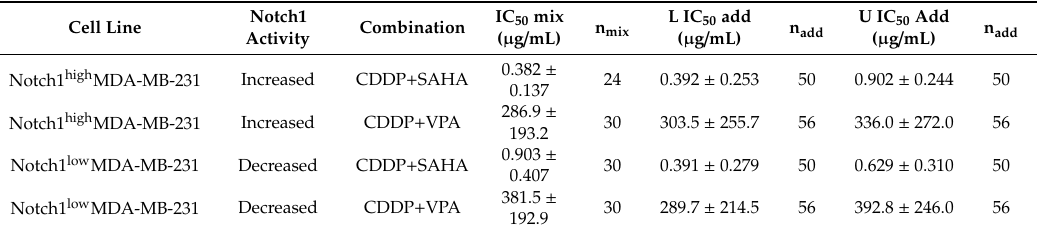
( A ) Isobologram illustrating additive interactions between CDDP and SAHA with respect to their anti-proliferative e ff ects on the MDA-MB-231 cells with the increased activity of Notch1 (Notch1 high MDA-MB-231); ( B ) isobologram illustrating additive interactions between CDDP and VPA with respect to their anti-proliferative e ff ects on the MDA-MB-231 cells with increased activity of Notch1 (Notch1 high MDA-MB-231); ( C ) isobologram illustrating additive interactions between CDDP and SAHA with respect to their anti-proliferative e ff ects on the MDA-MB-231 cells with decreased activity of Notch1 (Notch1 low MDA-MB-231); ( D ) isobologram illustrating additive interactions between CDDP and VPA with respect to their anti-proliferative e ff ects on the MDA-MB-231 cells with decreased activity of Notch1 (Notch1 low MDA-MB-231). The IC 50 ± S.E.M. for CDDP, SAHA, and VPA are plotted graphically on the X- and Y- axes, respectively. The lower and upper isoboles of additivity represent the curves connecting the IC 50 values for CDDP and SAHA, or VPA administered alone. The points A’ and A” depict the theoretically calculated IC 50 add values ( ± S.E.M.) for both, lower and upper isoboles of additivity. The point M on each graph represents the experimentally-derived IC 50 mix value ( ± S.E.M.) for the total dose of the mixture, which produced a 50% anti-proliferative e ff ect in the cancer cell line MDA-MB-231. The experimentally-derived IC 50 mix value is placed close to the point A’ for the lower isobole of additivity ( A ), ( B ), indicating additive interaction between CDDP and SAHA or CDDP and VPA in MDA-MB-231 breast cancer cells with increased expression of Notch1 (Notch1 high MDA-MB-231). The experimentally-derived IC 50 mix value is placed above the point A” ( C ) or close to the point A” for the upper isobole of additivity ( D ), indicating an additive interaction between CDDP and VPA, and additive interaction with a tendency towards antagonism between CDDP and SAHA in the MDA-MB-231 cells with the decreased activity of Notch1 (Notch1 low MDA-MB-231). Table 2. Type I isobolographic analysis of interactions (for non-parallel log-probit dose–response relationship curves (DRRCs) between CDDP and SAHA or VPA at the fixed-ratio combination of 1:1 in MDA-MB-231 with increased (Notch1 high MDA-MB-231) or decreased (Notch1 low MDA-MB-231) activity of Notch1 measured in vitro by the MTT assay. Results are presented as median inhibitory concentrations (IC 50 values in µ g / mL ± S.E.M.) for two-drug mixtures, determined either experimentally (IC 50 mix) or theoretically calculated (IC 50 add) from the equations of additivity (Tallarida 2006, 2007), blocking proliferation in 50% of tested cells in cancer cell lines (MDA-MB-231 with increased or decreased activity of Notch1) measured in vitro by the MTT assay. n mix—total number of items used at those concentrations whose expected anti-proliferative e ff ects ranged between 16% and 84% (i.e., 4 and 6 probits) for the experimental mixture; n add—total number of items calculated for the additive mixture of the drugs examined; L IC 50 add value calculated from the equation for the lower line of additivity; U IC 50 add value calculated from the equation for the upper line of additivity. Statistical evaluation of data was performed with an unpaired Student’s t-test.